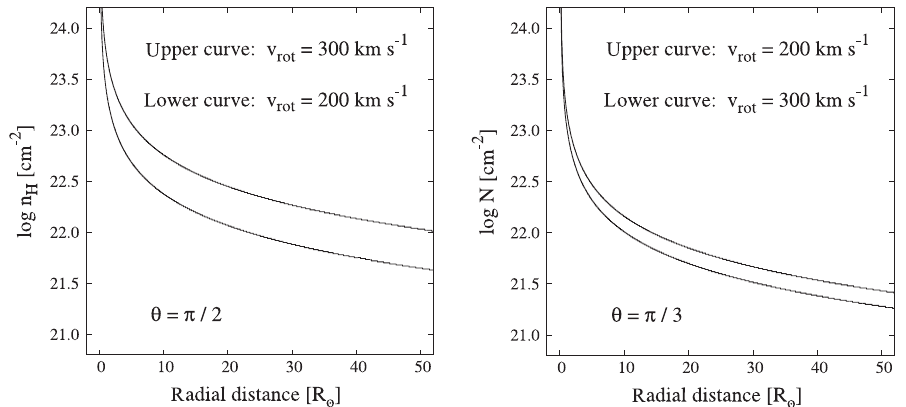
Fig. 4. Examples of the calculated column density N ( (cid:18) ) of the neutral hydrogen atoms as a function of the radial distance from the center of the hot star for two different rotational velocities, 200 and 300 km s − 1 . The angle between the polar axes of the hot star and the line of sight is (cid:18) = (cid:25)= 2 (equatorial plane) for the left panel and (cid:18) = (cid:25)= 3 for the right panel. In these calculations we assumed that the mass-loss rate of the hot star is 10 − 6 M ⊙ yr − 1 , and the radius of the hot star is 0.18 R ⊙